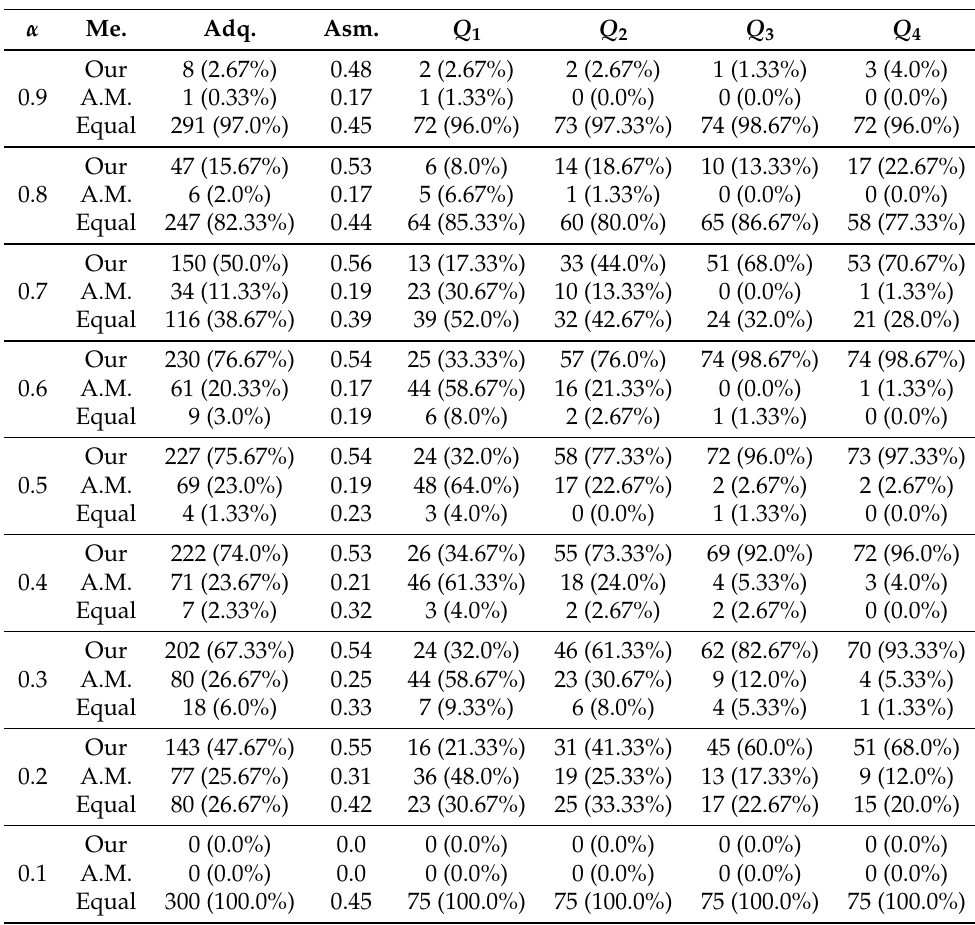
Table 6. Study of the parameter α with a 9-Likert scale.